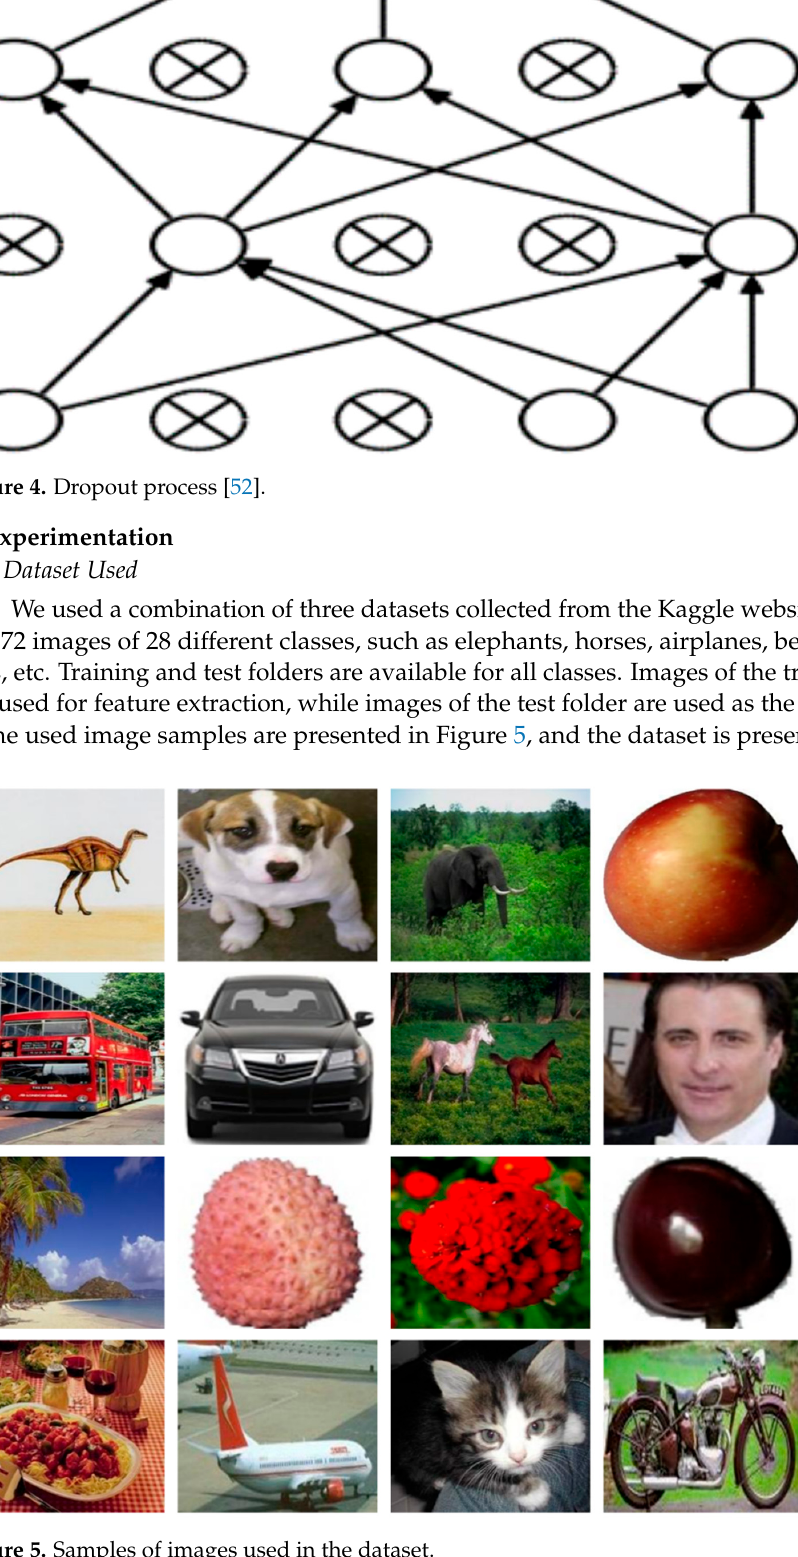
Figure 5. Samples of images used in the